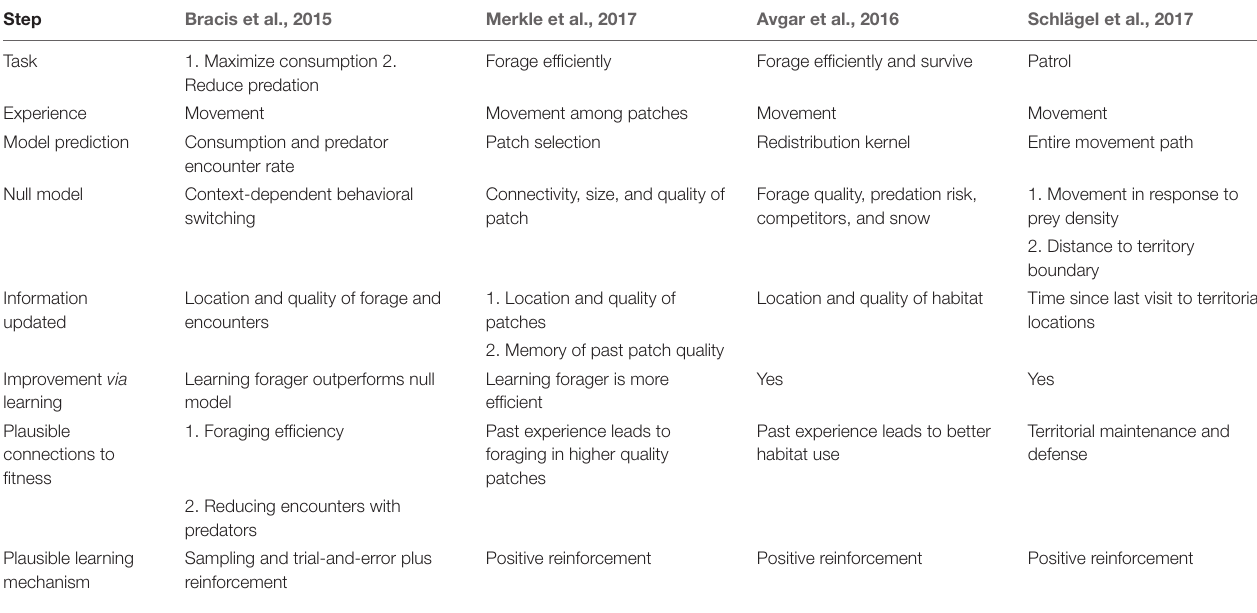
TABLE 3 | Models for learning and animal